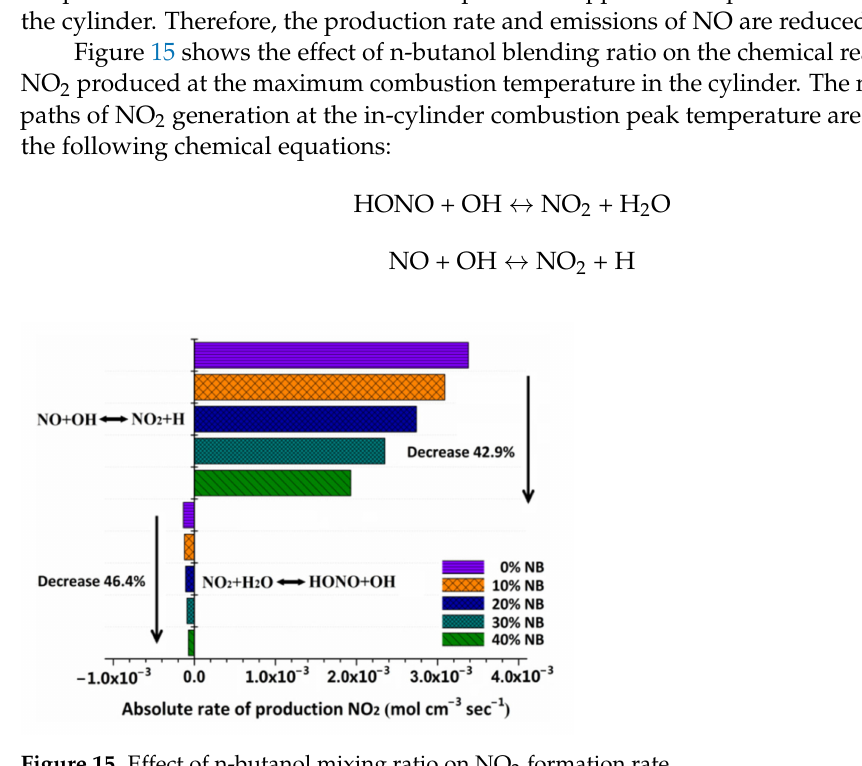
Figure 15. Effect of n-butanol mixing ratio on NO 2 formation